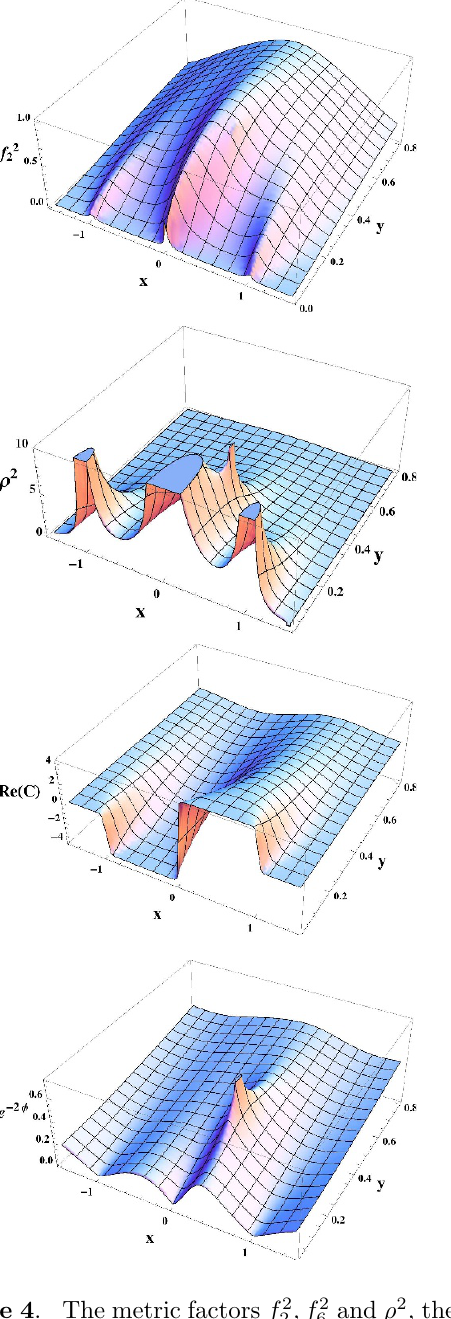
; f 2 and (cid:26) 2 , the real and imaginary parts of the two-form potential 2 6